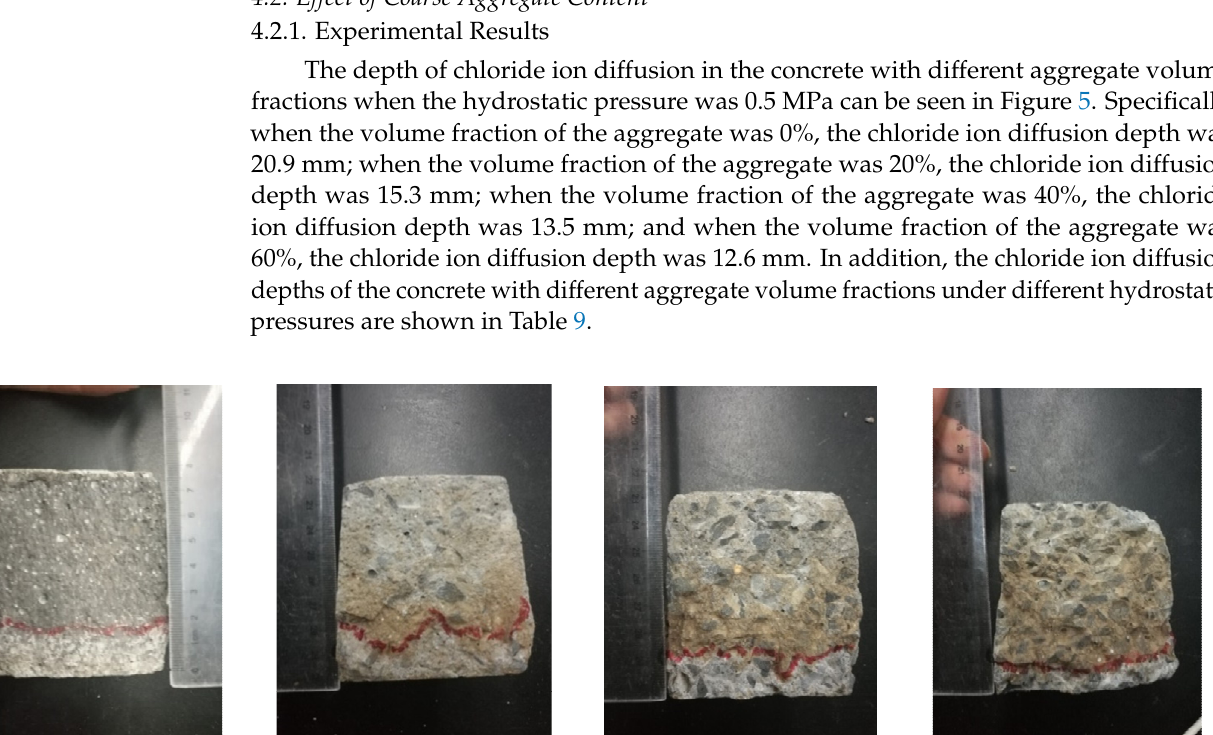
( d ) 60% Figure 6. Simulation results of chloride ion diffusion under different volume fractions of the aggregate under a hydrostatic pressure of 0.5 MPa. The deviation value of the data in Table 8 shows that the error of the physical test results and simulation results increased after the introduction of a coarse aggregate into the cementitious materials. The maximum error of the mortar test block comparison re- sults was only 7.8%, while the maximum error of the concrete test block comparison re- sults was 13.8%. This is a sharp increase, and the dispersion of the concrete contrast error was large. At the same time, the average contrast error of the mortar test block was 6.54%,